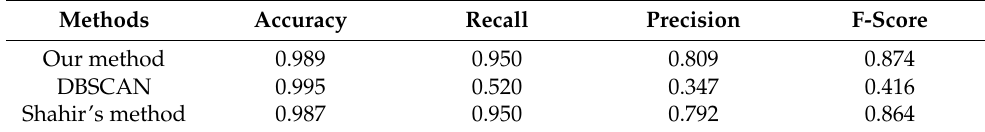
Table 3. Effectiveness of this method in abnormal behavior detection for ship thematic attributes. Table 2. Effectiveness of our method in abnormal behavior detection for ship spatial attributes.